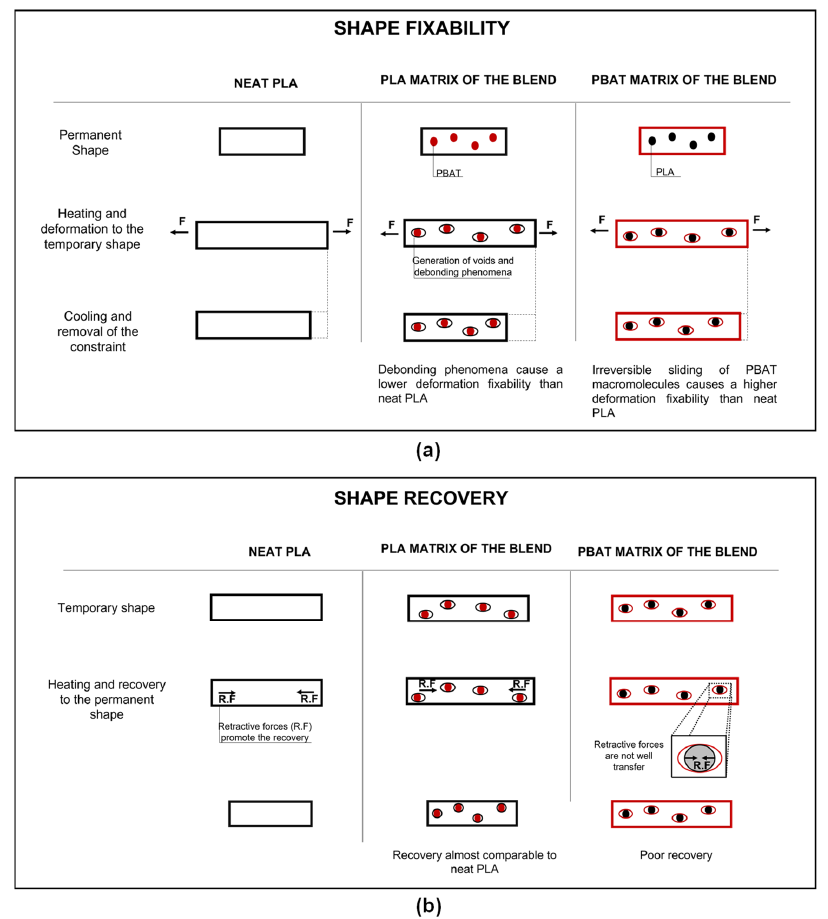
Figure 10. Schematization of the proposed mechanism for the shape memory behavior of the produced blends. Model of ( a ) strain fixity and ( b ) strain recovery behavior.